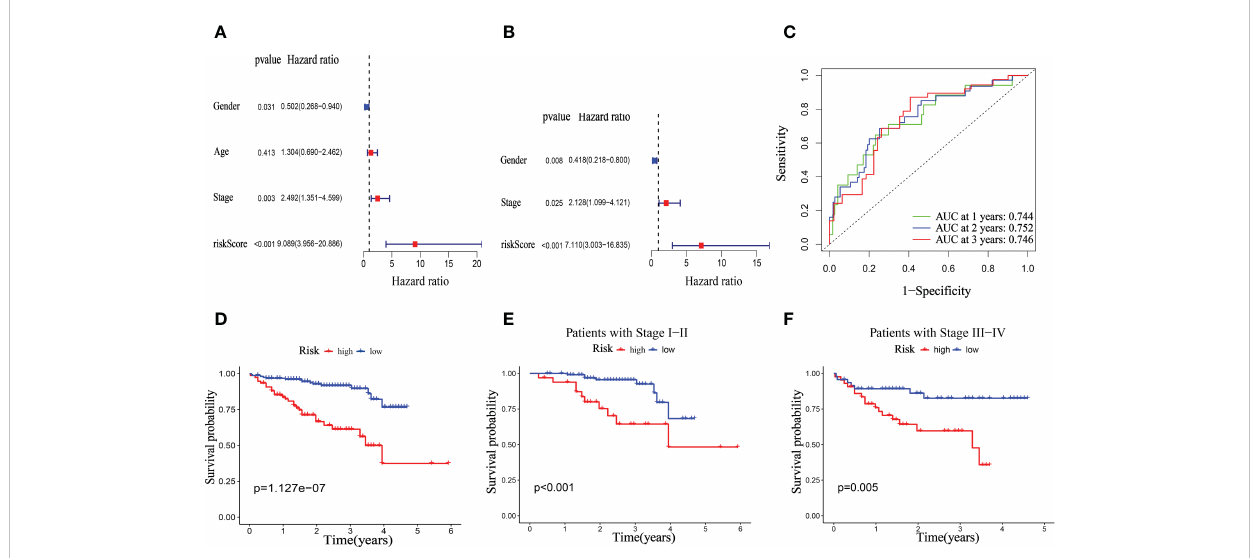
FIGURE 9 Univariate and multivariate Cox regression analyses for OS in ICGC test group. Univariate (A) and multivariate (B) Cox regression analysis of riskScore and clinicopathological parameters in ICGC dataset. (C) Time-dependent ROC curve of riskScore. (D) Kaplan – Meier analysis between riskScore- de fi ned groups. (E) Kaplan – Meier analysis between riskScore-de fi ned groups in patients with stage I-II. (F) Kaplan – Meier analysis between riskScore- de fi ned groups in patients with stage